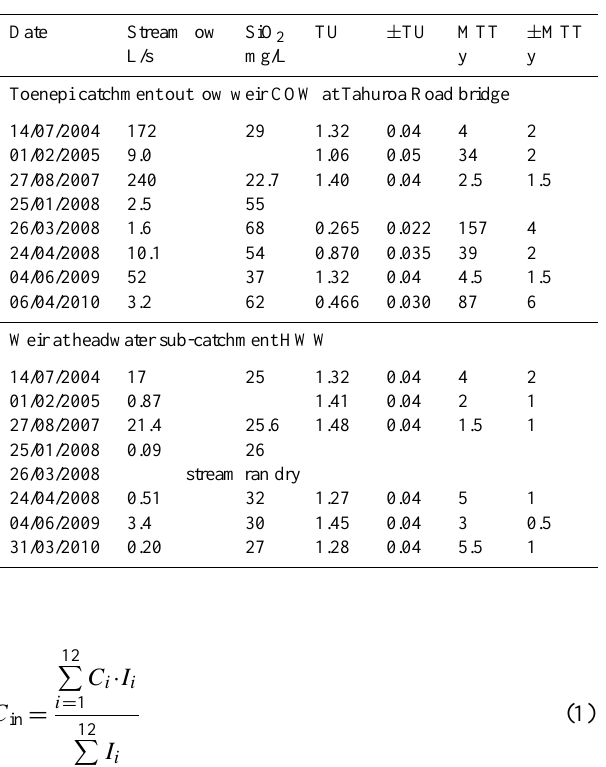
Table 1. Streamflow, silica and tritium concentrations, and mean transit times (MTT) for the Toenepi stream at the catchment outflow weir (COW) and at a headwater weir (HWW). Catchment outflow weir streamflow data from NIWA, headwater weir streamflow data from Lincoln Ventures Ltd. ± TU is the one-sigma standard error for the measured tritium concentrations, and ± MTT describes the MTT deviation which would still match the measured tritium con- centration within its standard